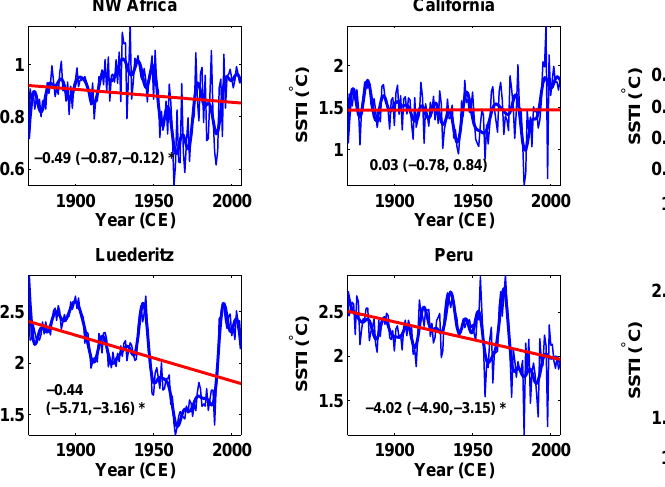
Fig. 7. Trends of coastal upwelling derived from the HadISST dataset (Rayner et al., 2003) for the period 1960–2006. The up- welling shows an increase after 1960 in all regions except Peru. The value of the slope and its 95% confidence interval are given in each panel (in units of 10 − 3 ◦ Cyr − 1 ). A ∗ indicates that the slope is statistically significant at the 0.05 level. Also shown are the un- smoothed time series (thin